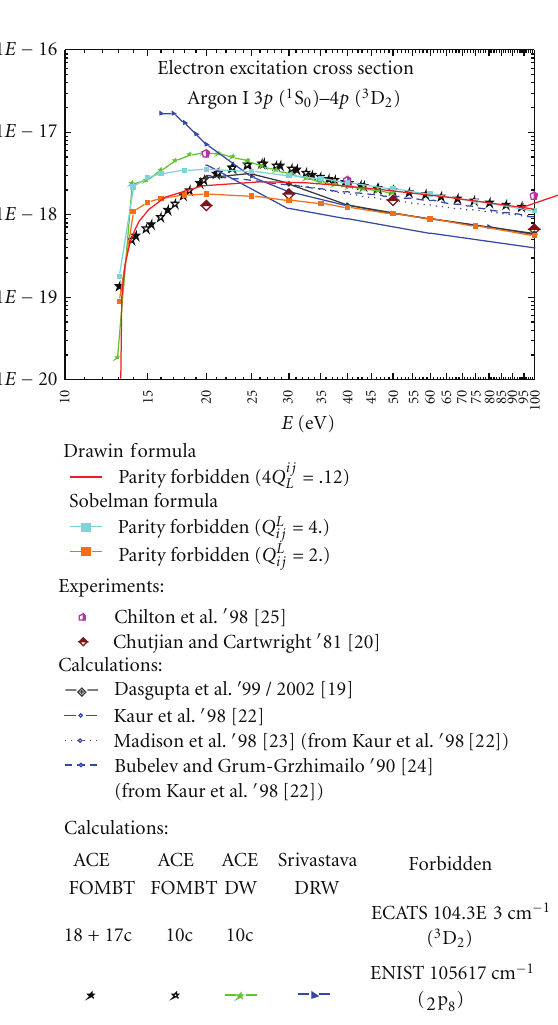
Figure 4: Electron excitation cross section of Ar I 3 p ( 1 S 0 )–4 p ( 3 D 2 ).